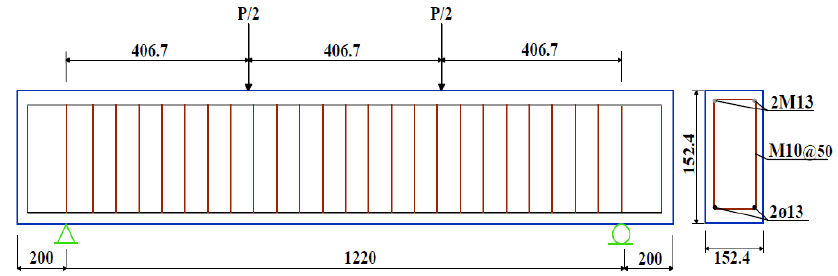
Figure 11. Detailed Geometry of Papakonstantinou et al. Specimens (N-1) [51,52].